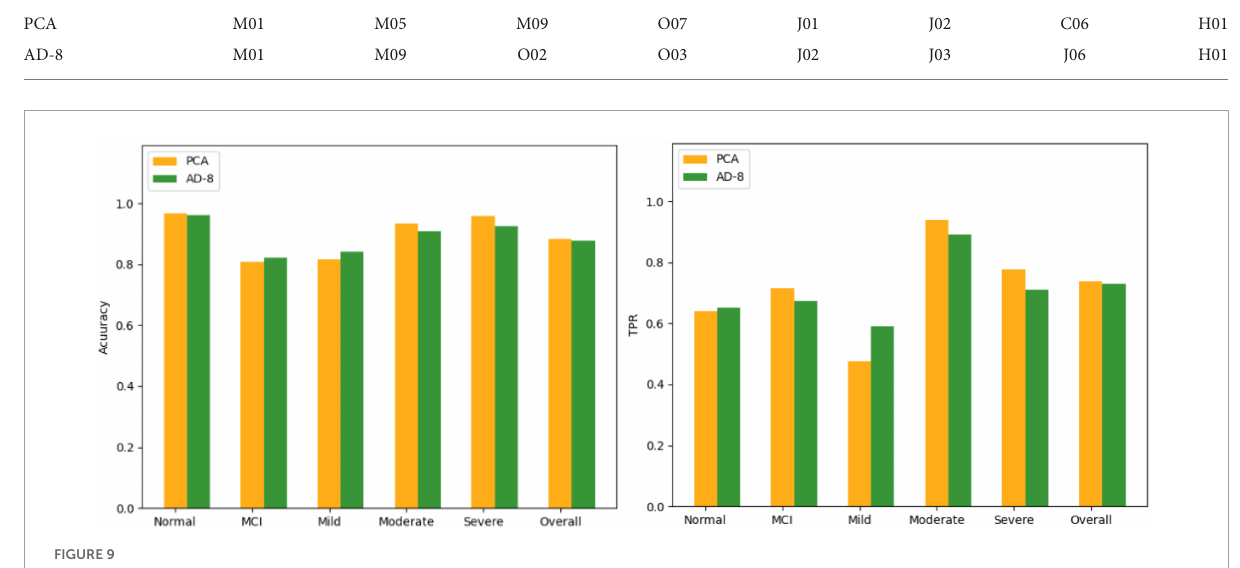
FIGURE9 Comparison of PCA and AD-8